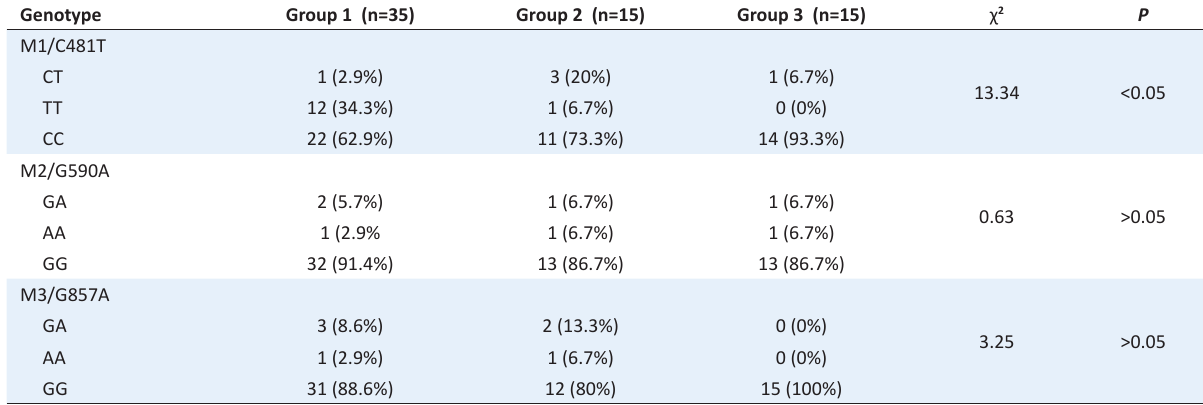
Table 2. Descriptive and comparative statistics of the genotypes frequencies of the studied NAT2 gene SNPs in bladder cancer patients (group 1), pathological controls (group 2) and healthy controls (group 3) using chi-square test Genotype